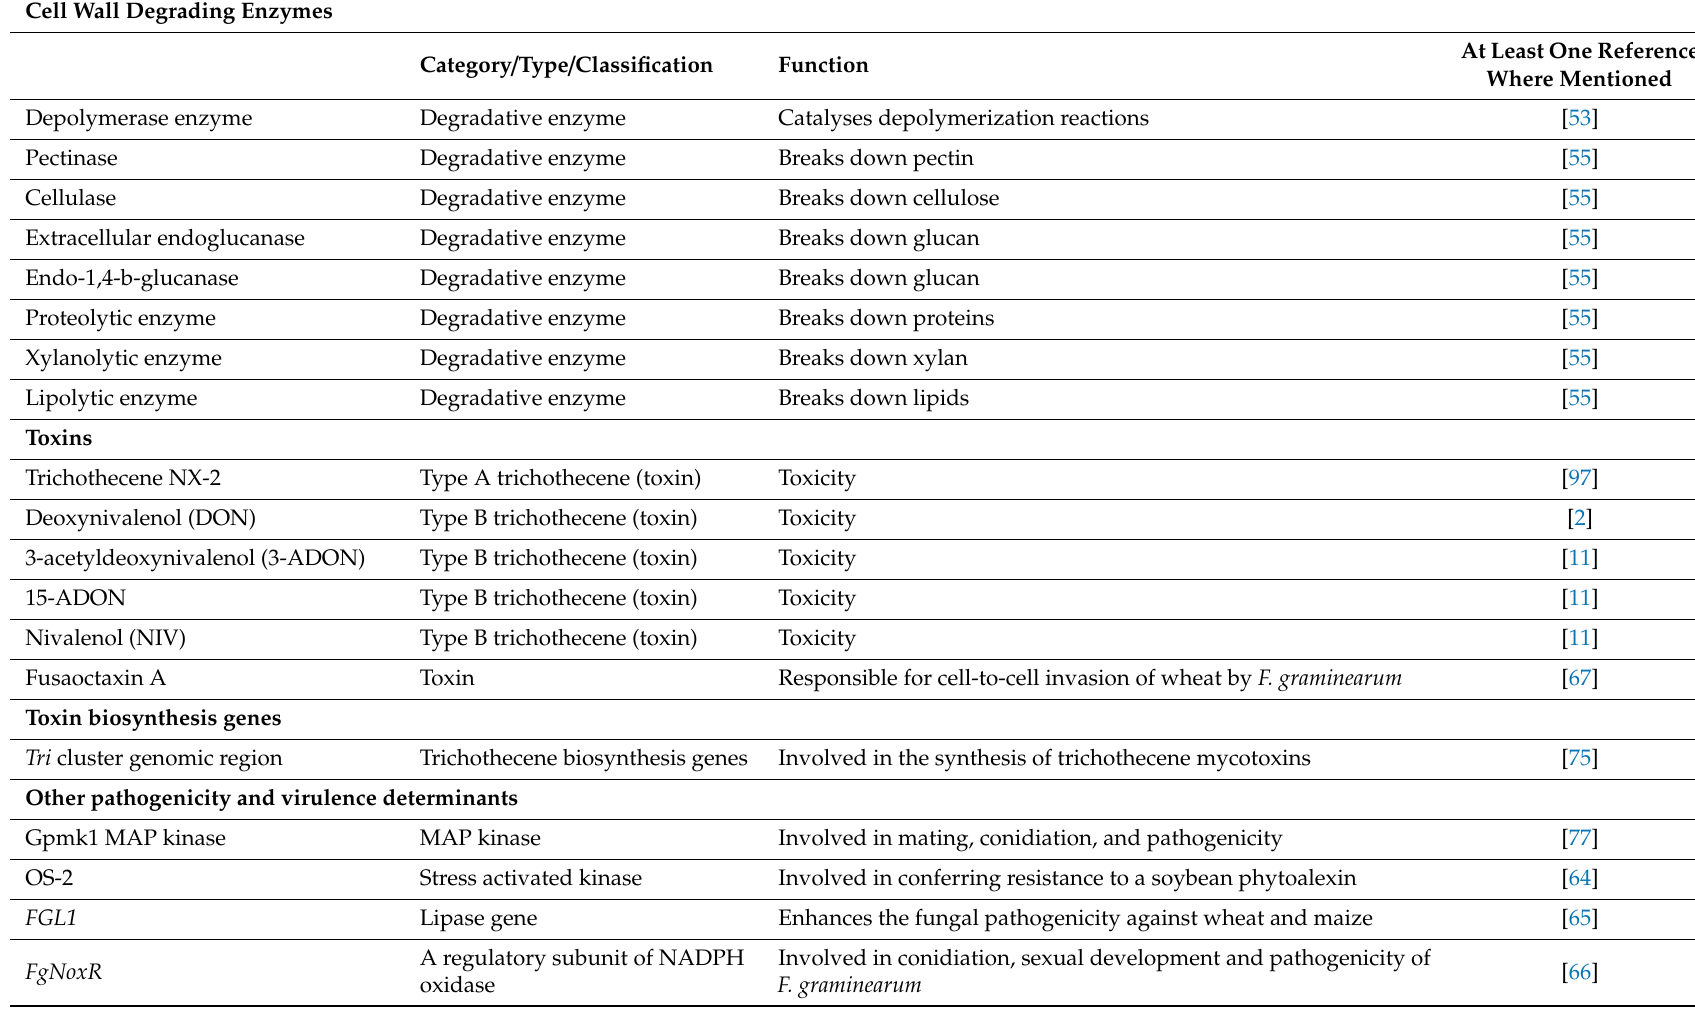
Table 1. List of pathogenicity and virulence factors of Fusarium graminearum